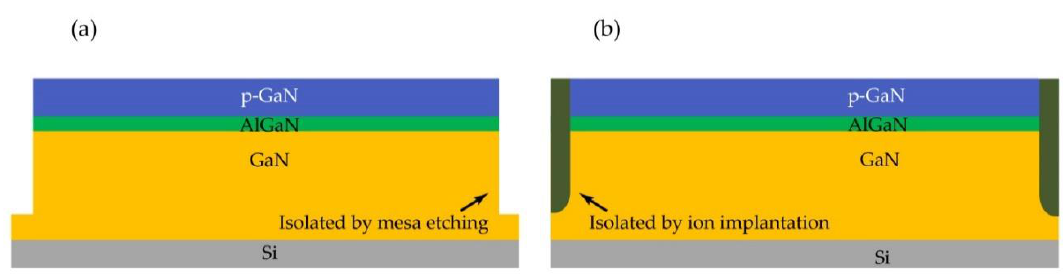
Figure 4. Schematic cross-section of ( a ) mesa etching and ( b ) ion implantation for device isolation.